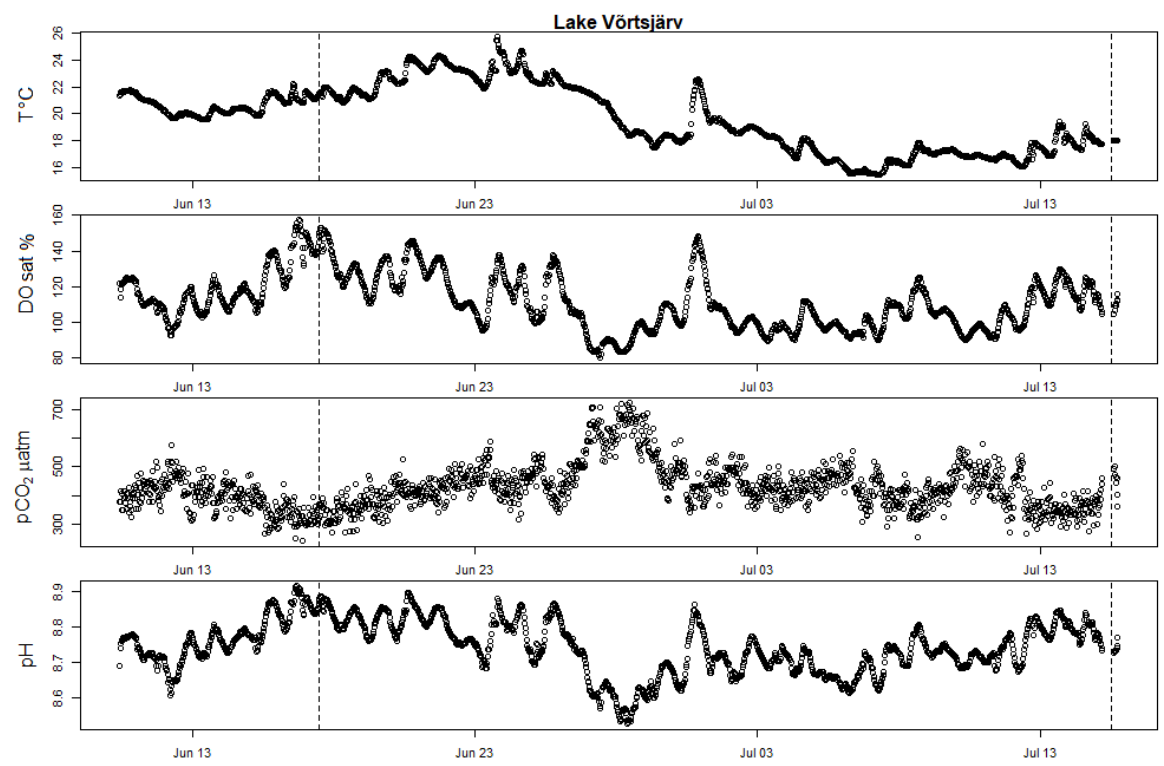
Figure A4. High-frequency bouy measurements showing seasonal evolution of surface water T (in degrees Celsius), DOsat, pCO 2 partial pressure and pH in V õ rtsjärv. The two vertical dotted bars mark the date of the two incubation campaigns (17.6.2019 and 15.7.2019).